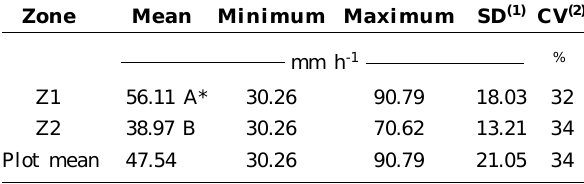
Table 5. Descriptive statistics and Student’s t